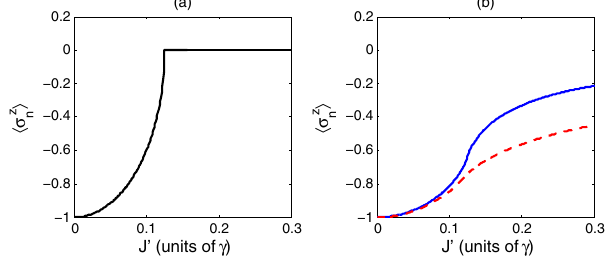
FIG. 3. h σ z for (a) two atoms and (b) an infinite chain with n i J ¼ 0 (blue solid line) and J ¼ 0 . 1 γ (red dashed line). The critical point is J 0 ¼ γ = 8 for all cases. Panel (a) is independent of J